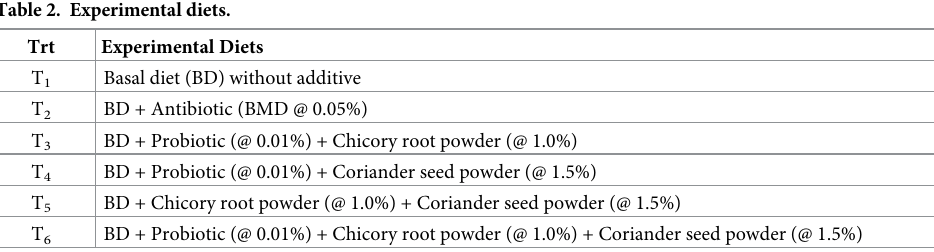
Table 2. Experimental diets. Trt